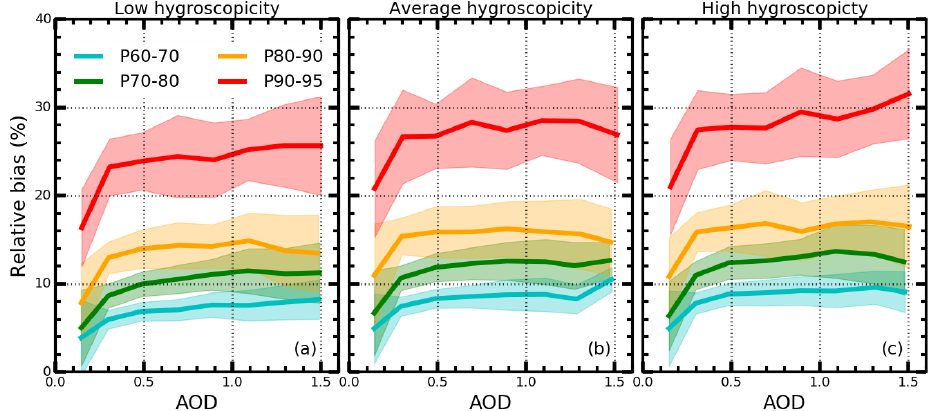
Figure 5. Relative biases of the retrieved σ ext under different AOD, PNSD, hygroscopicity and RH profile conditions. Different colors represent different RH profiles. Panel (a) is derived from low hygroscopicity, panel (b) results from the mean hygroscopicity and panel (c) is for high